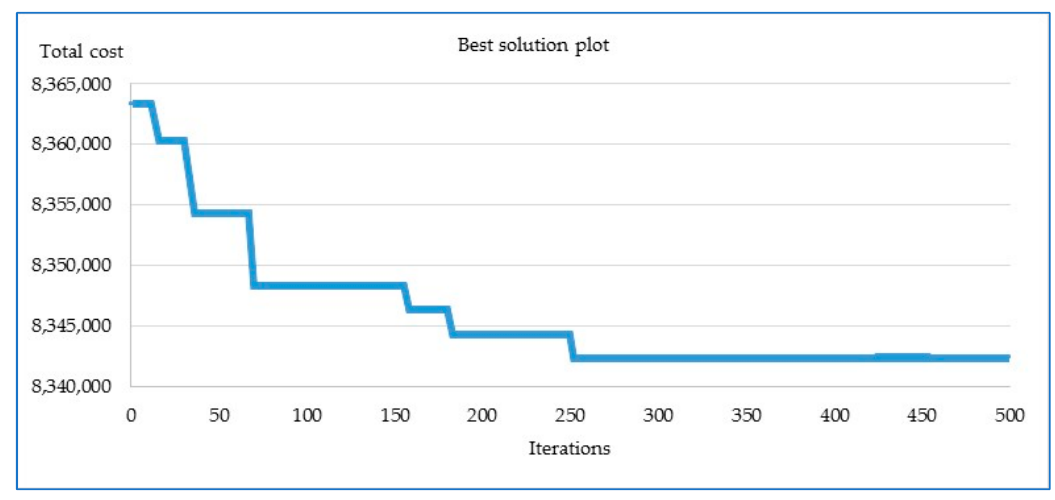
Figure 8. ALNS behaviors during the simulation run.